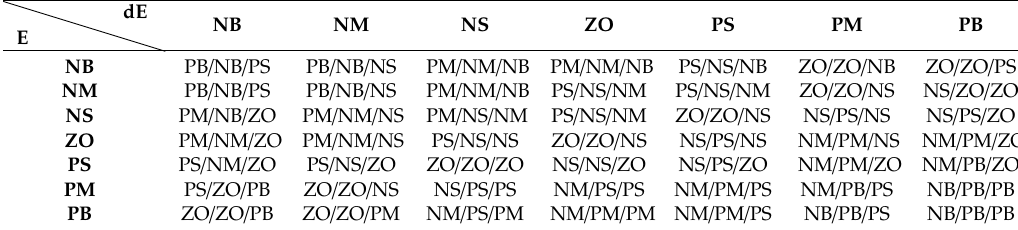
Table 5. Fuzzy rule base table of ∆ K P (t), ∆ K i (t), ∆ K d (t).